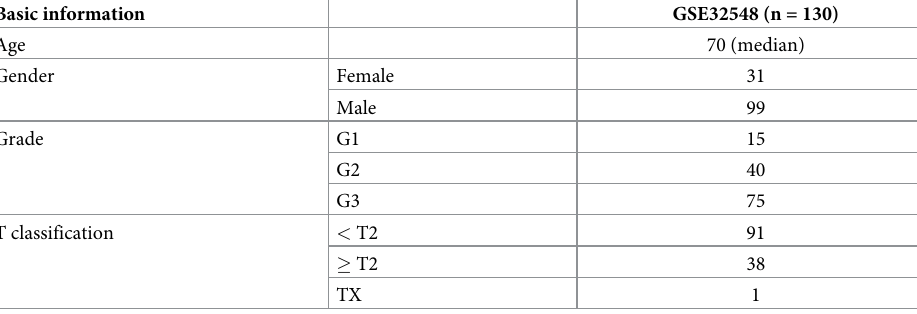
Table 3. Characteristics of the BC patients obtained from the GEO